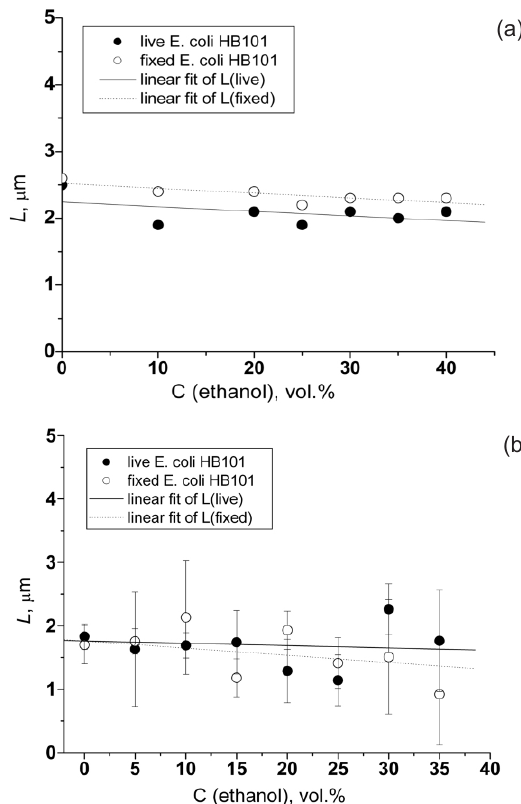
Figure 8. (a) The dependence of the average bacteria length ( L ), determined by electric light scattering (ELS) (Eqs. 2, 3), on the ethanol concentration for live and fixed E. coli HB101 cells. The deviations are in the limits of the symbols. (b) The dependence of the average bacteria length ( L ), determined by dynamic light scattering (DLS), on the ethanol concentration for live and fixed E. coli HB101